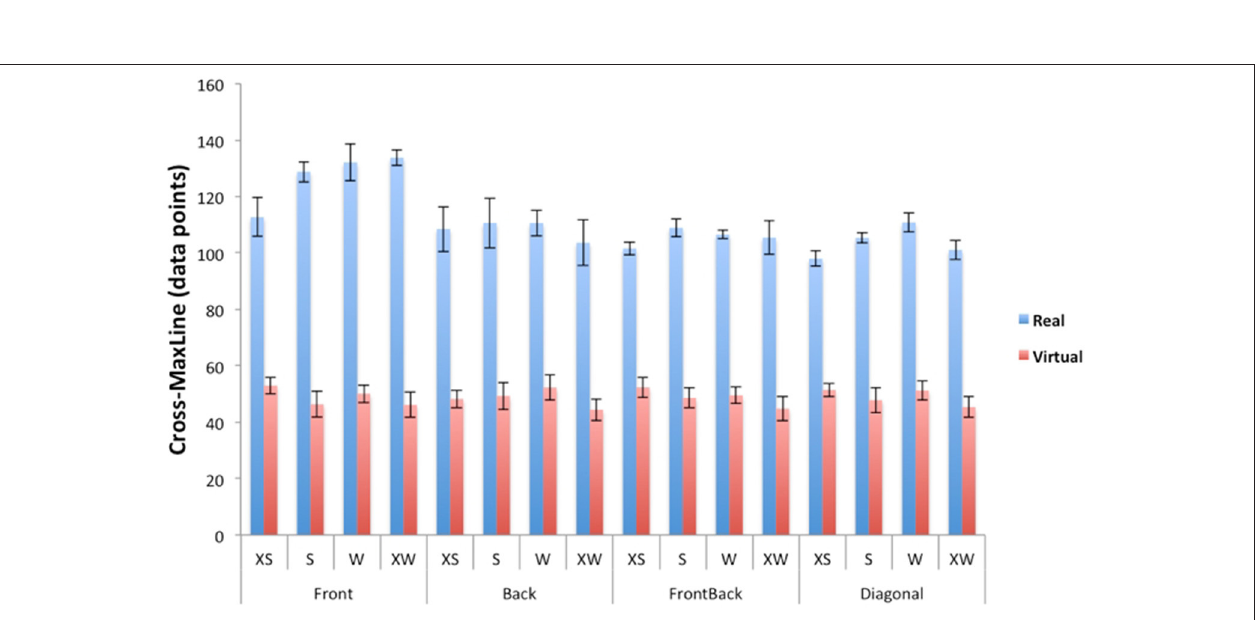
FIGURE 8 | CML values for real compared to virtual groups for each of 4 densities and 6 dyads. All real group conditions were significantly greater than virtual group conditions (Bonferroni corrected p ≤ 0.01). XS = 0.5m apart, S = 1m apart, W = 1.5m apart, XW = 2.5m